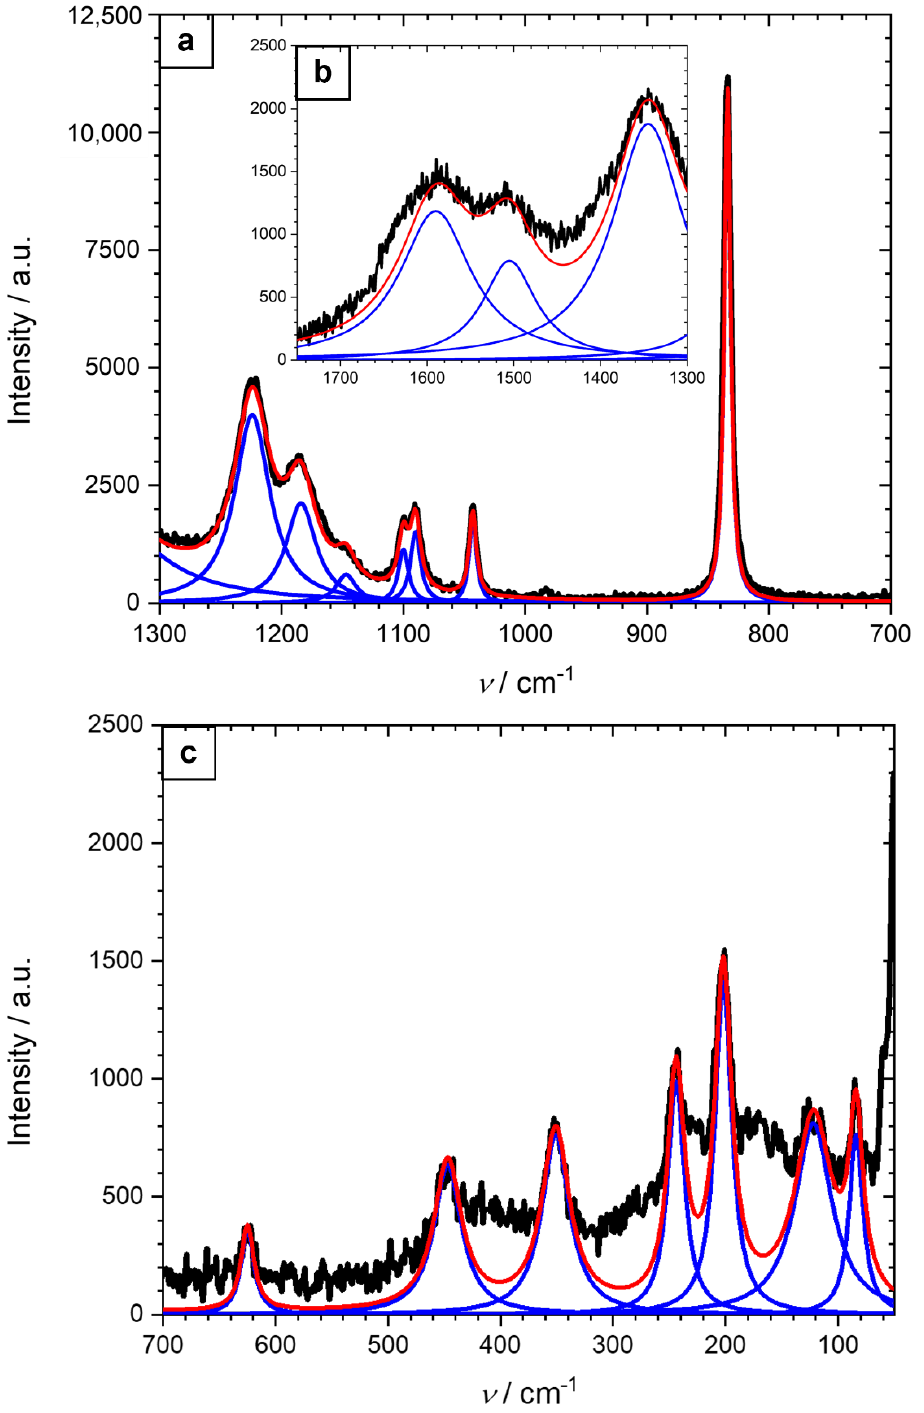
Figure 8. Resolved ( a – c ) 785 nm Raman spectra for johannite (NMW 67.154GR.69). The thick black line represents the experimental data, the blue lines are the individual peaks, and the red line is the overall resolved fit. Intensity is given in arbitrary units (a.u.).